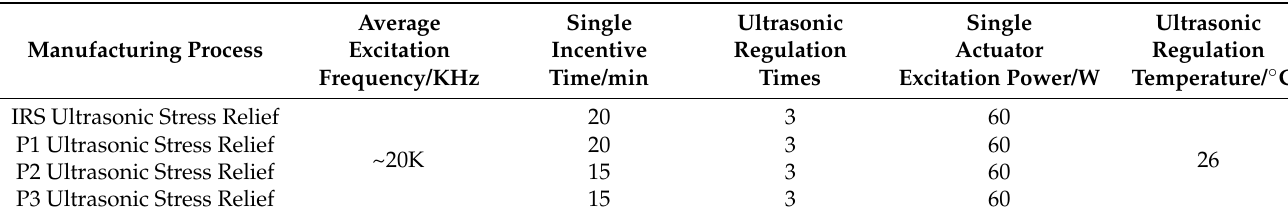
Figure 5. USR system: 1 is support foundation, 2 is aluminum alloy plate, 3 is vacuum sucker, 4 is fixed plate, 5 is ultrasonic transducer, 6 is ultrasonic power. Table 3. Control process